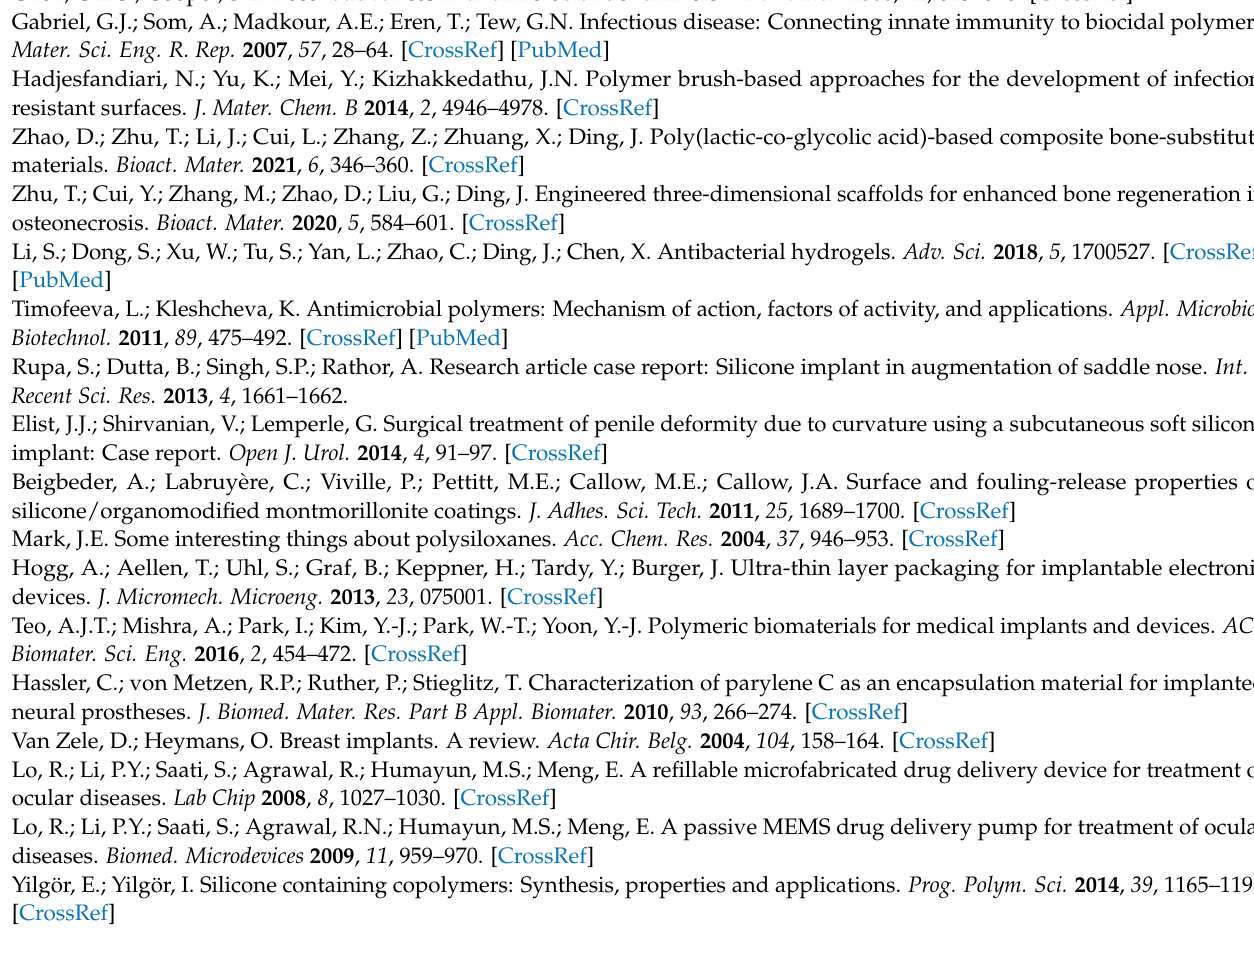
Figure S3: Crystal structure of Cu-MOF, Figure S4: FT-IR spectrum of PS and